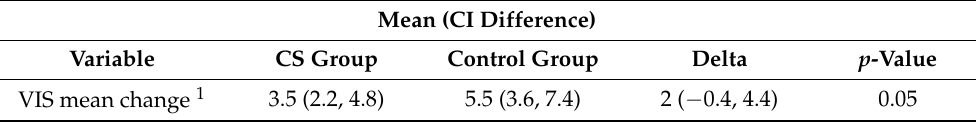
Table 3. Secondary